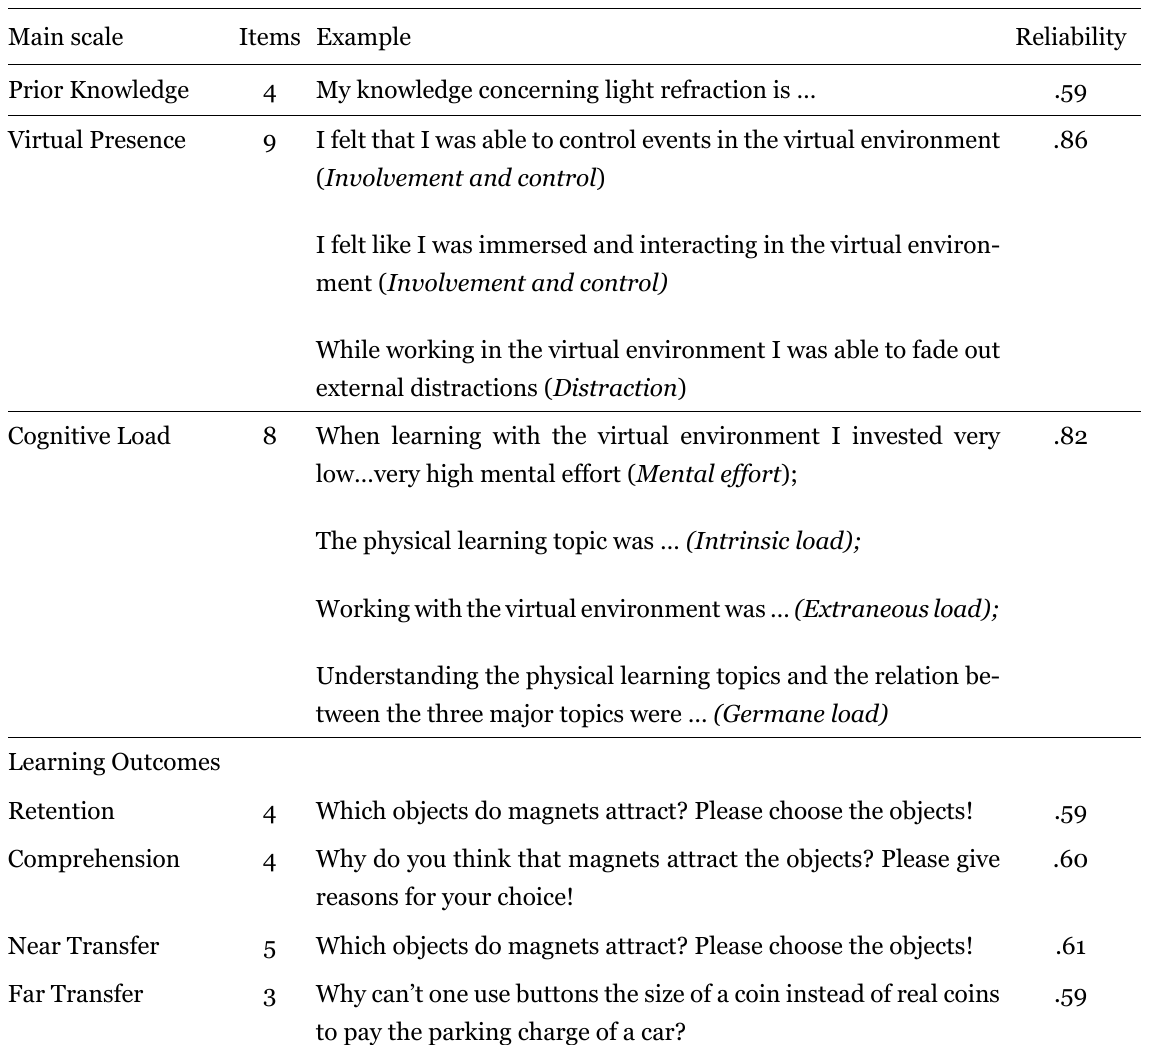
The Scales of Questionnaire and their